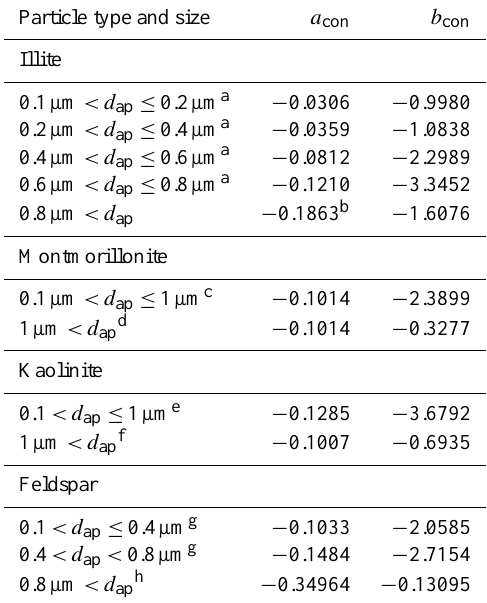
Table 3. Values of contact freezing constants in Eq. (10). Based on data from a Hoffmann et al. (2013b); b Diehl et al. (2012); c Ex- trapolation; d and f Pitter and Pruppacher (1973), used in Diehl et al. (2006); d Hoffmann et al. (2013a); g N. Hoffmann and A. Kiselev (personal communication, 2014); h K. Diehl and S. K. Mitra (per- sonal communication,